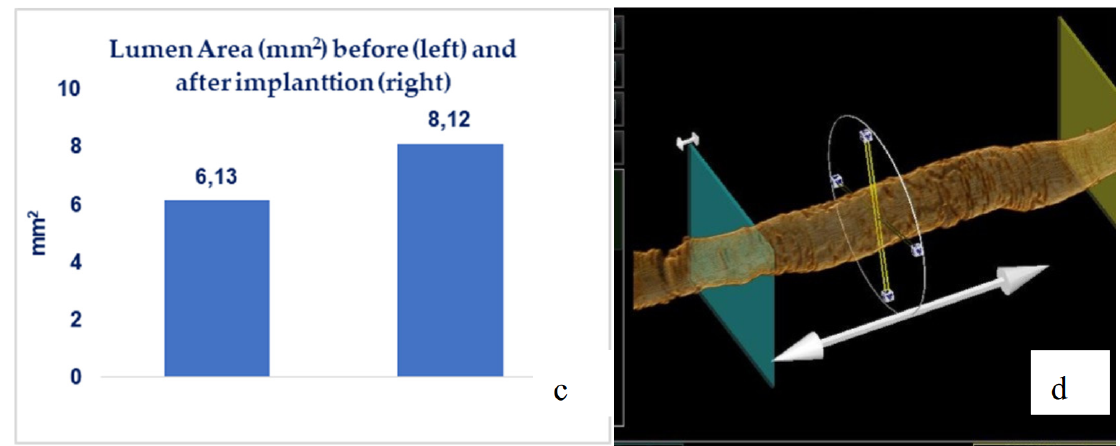
Figure 13. Acute outcome after PLGA/PLLA blend polymer stent implantation in coronary angiography ( a ) and optical coherence tomography ( b ). Lumen area increase before and after implantation ( c ). Geometrical view of vessel after stent implantation ( d ).